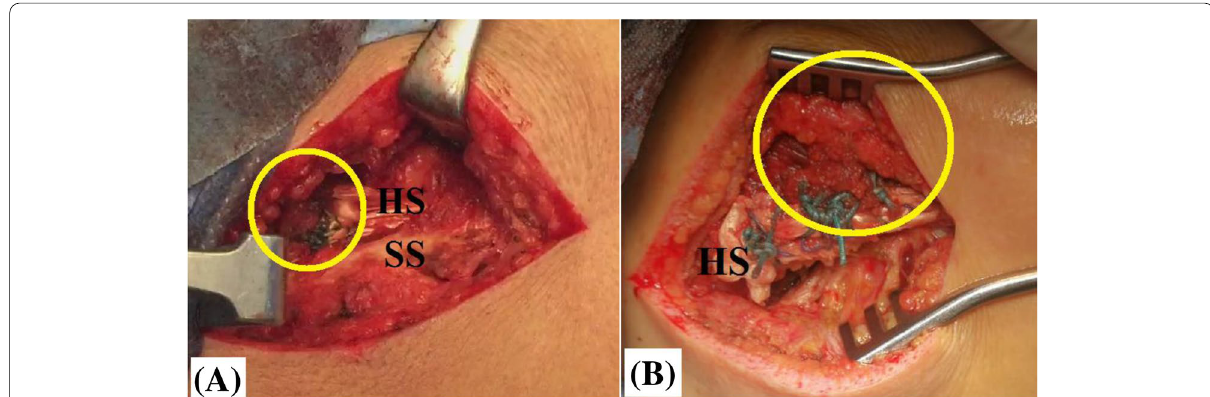
Fig. 11 A, B demonstrate sutured looped ends of the hamstring sheet to the released middle trapezius tendon (marked in yellow circle) by #5 − non‑absorbable sutures in currently reported technique of middle trapezius tendon transfer in the right shoulder; A, Pulvertaft fashion of suturing; B , side‑to‑side fashion of suturing; HS, hamstring sheet; SS, scapular